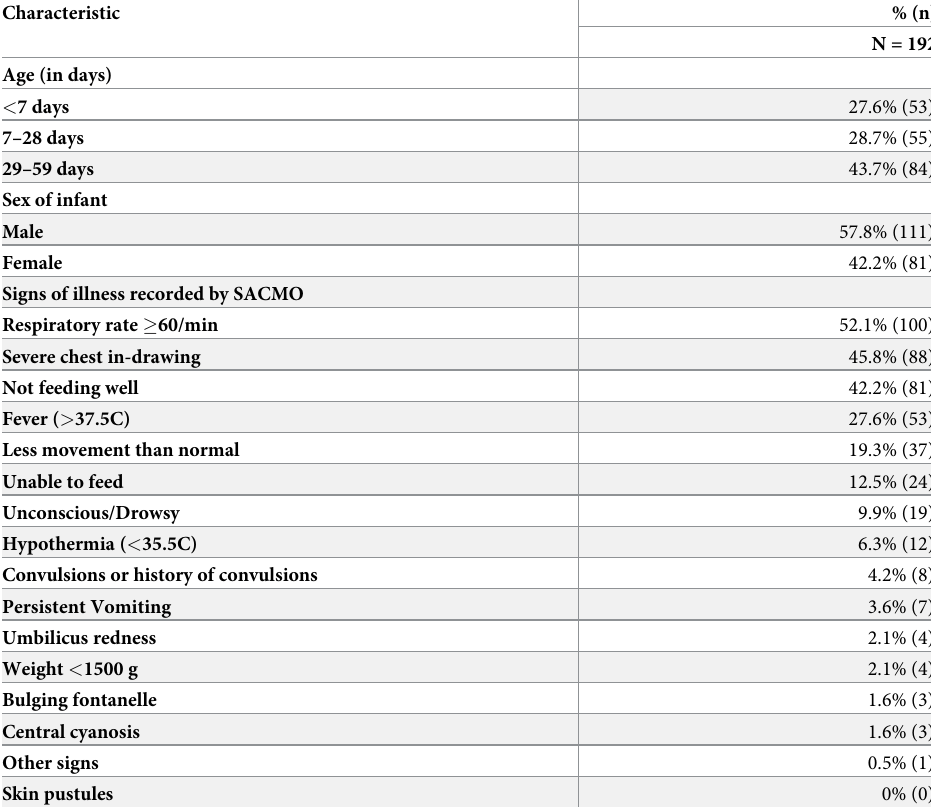
Table 1. Descriptive characteristics of sick young infants classified as PSBI at health